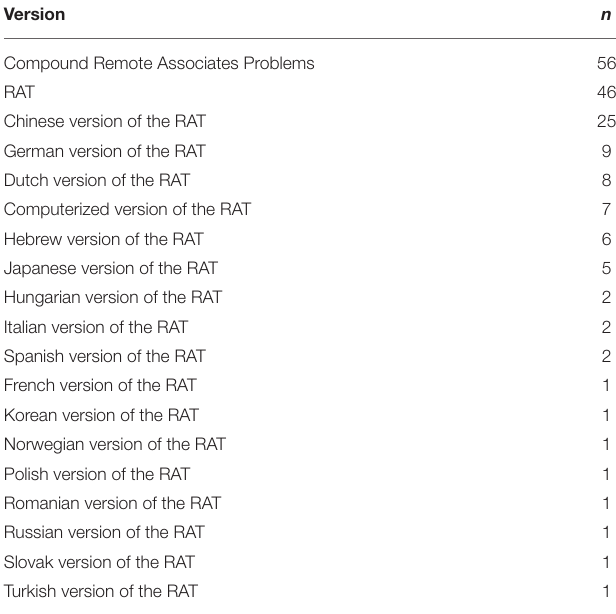
TABLE 2 | The number of RAT versions.